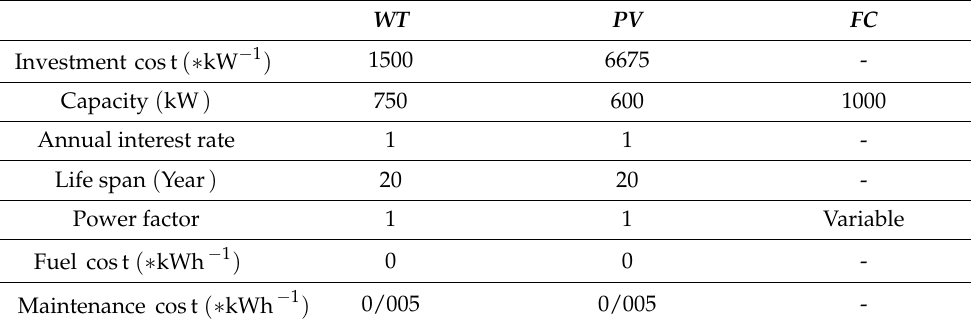
Table 1. Distributed production cost data.